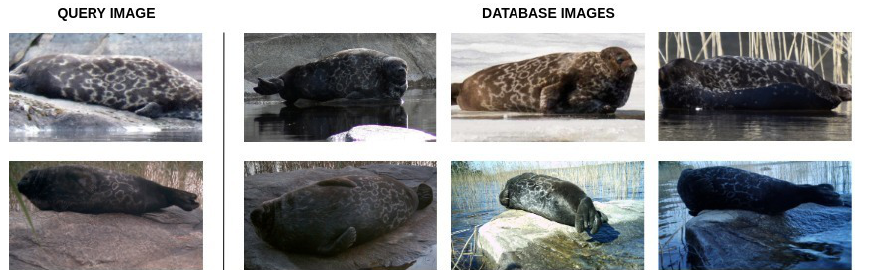
Figure 1. Examples from the database and the query datasets. Each row contains images of an individual seal. For each image from the query dataset ( left ), there exists a corresponding subset of images from the database ( right